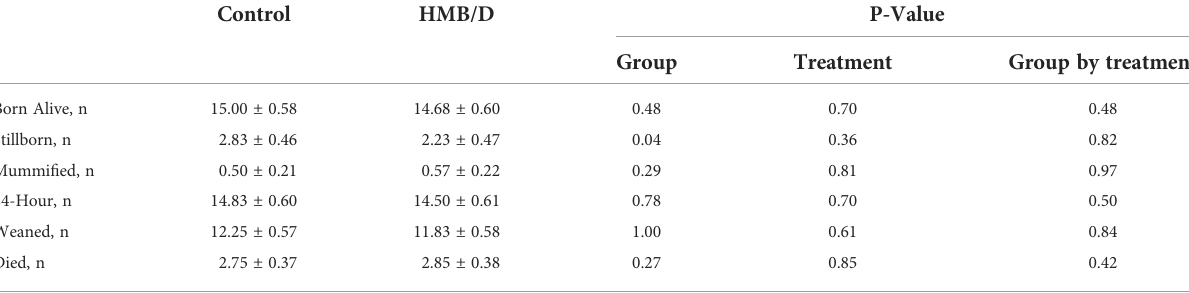
TABLE 4 The effect of supplementing calcium beta-hydroxy-beta-methylbutyrate and vitamin D (HMB/D) during late gestation and lactation on number of piglets per sow. a Control